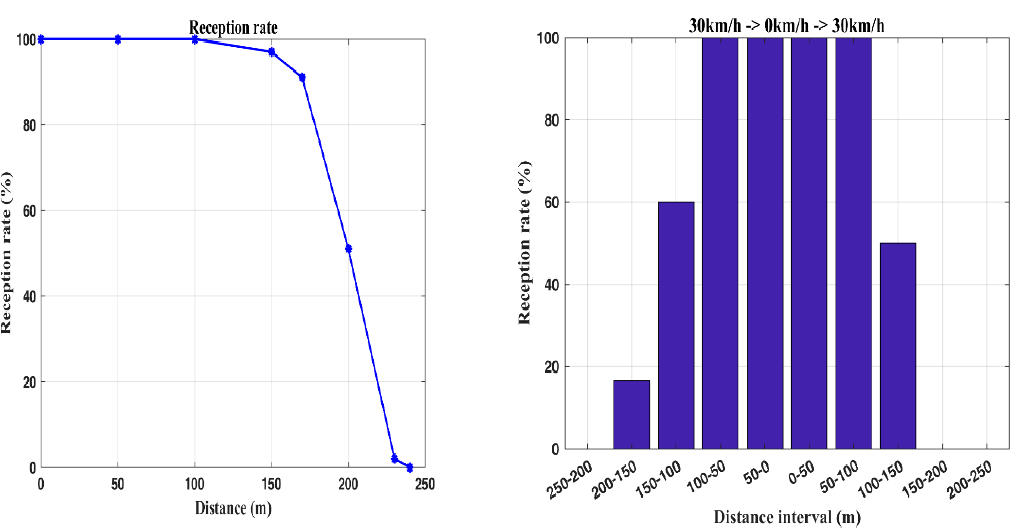
Figure 9. Reception rate at different distances (left) ; the reception rate of different distances when passengers get on and off: 30 km/h -> 0 km/h -> 30 km/h (right).